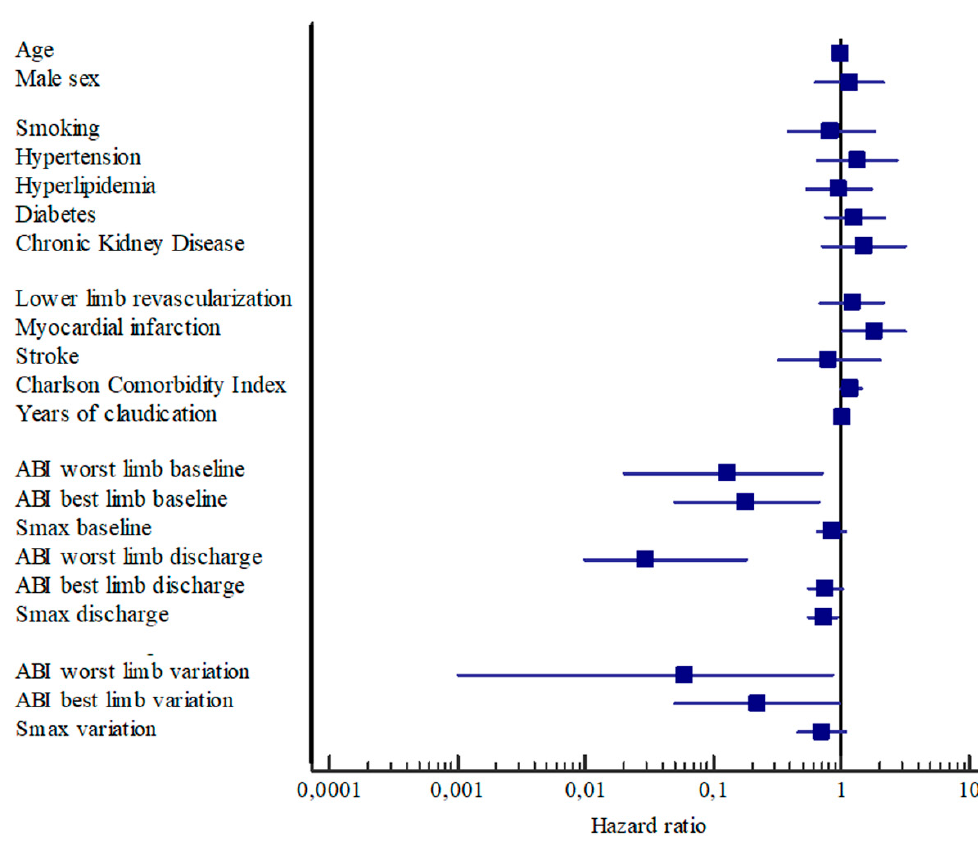
Figure 4. Forest plot showing association between PAD-related revascularizations and study variables in the whole population.